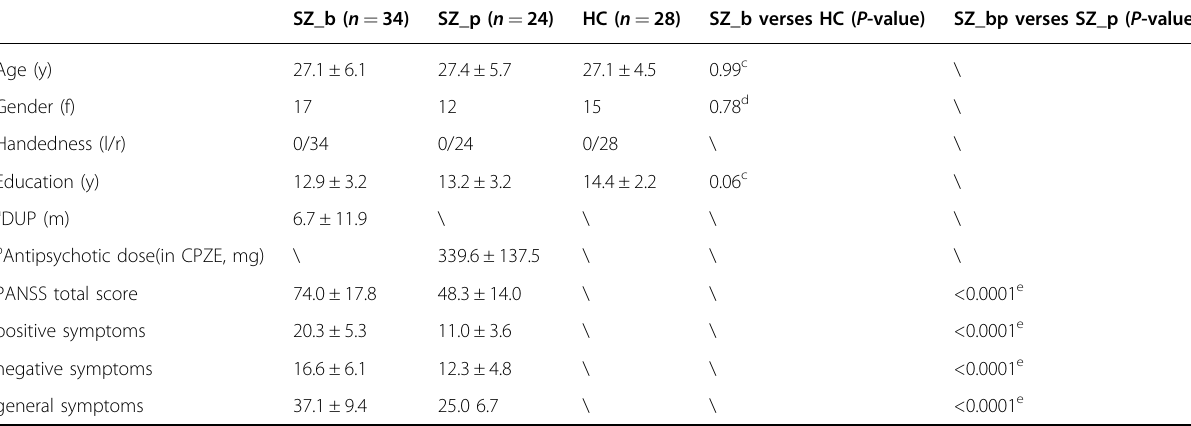
Table 1 Demographics and clinical characteristics from study